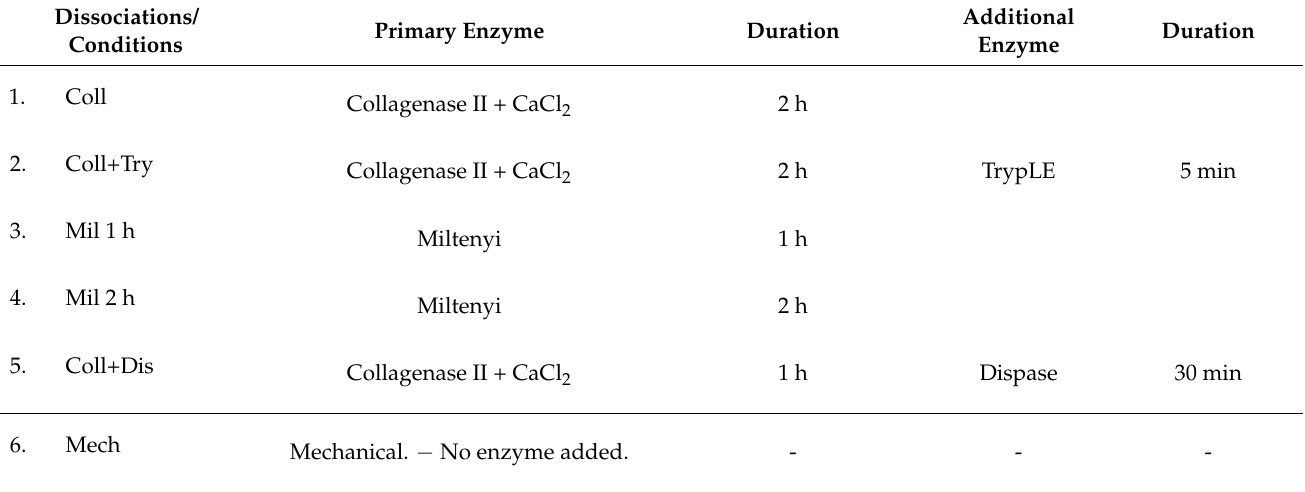
Table 1. The six tumor dissociation methods evaluated using the CyTOF